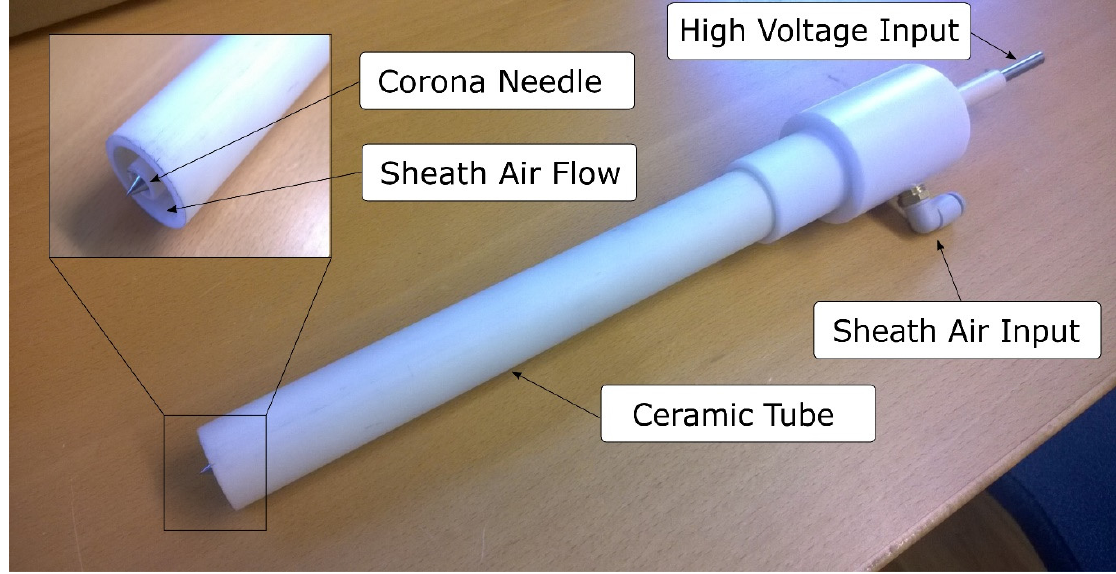
Figure 1. Design of the shielded corona charger